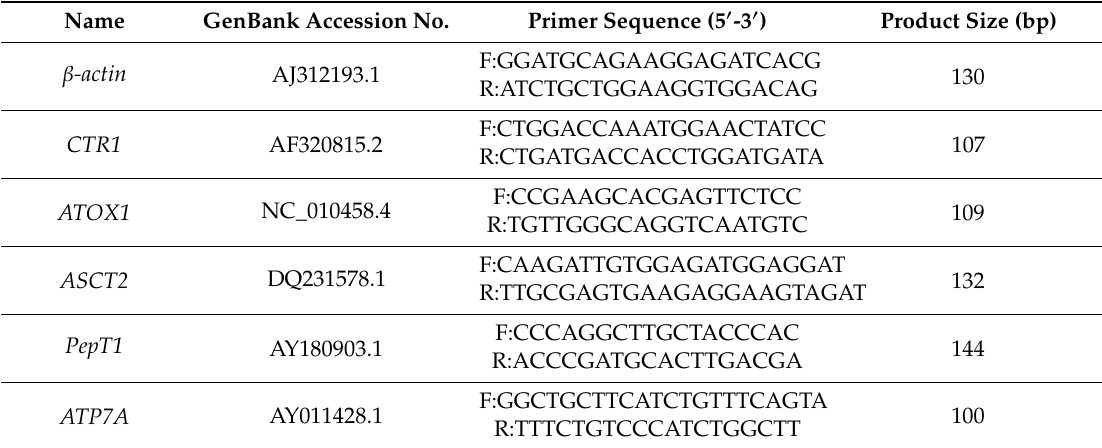
Table 1. Oligonucleotide primers used for